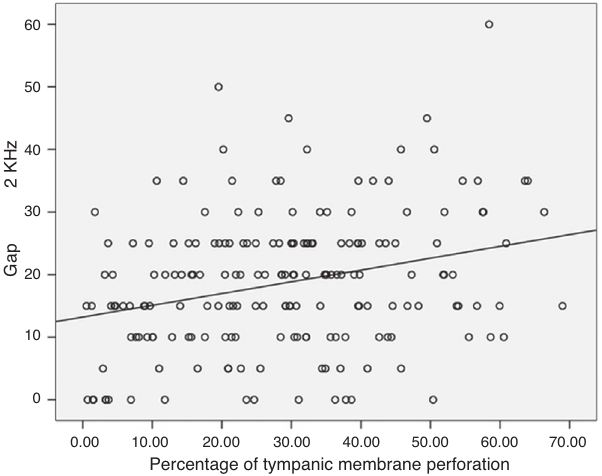
Figure 4 Correlation between the percentage of tympanic membrane perforation and air-bone gap observed at a 2000 Hz